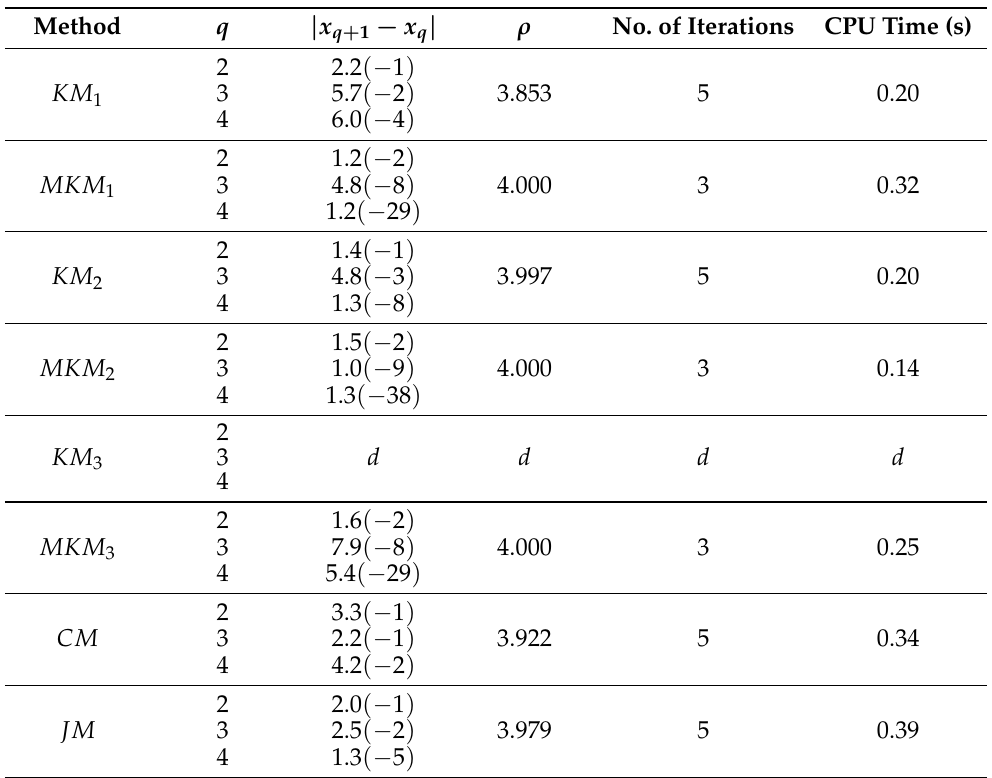
Table 7. Example 4(d) with initial guess x 0 =